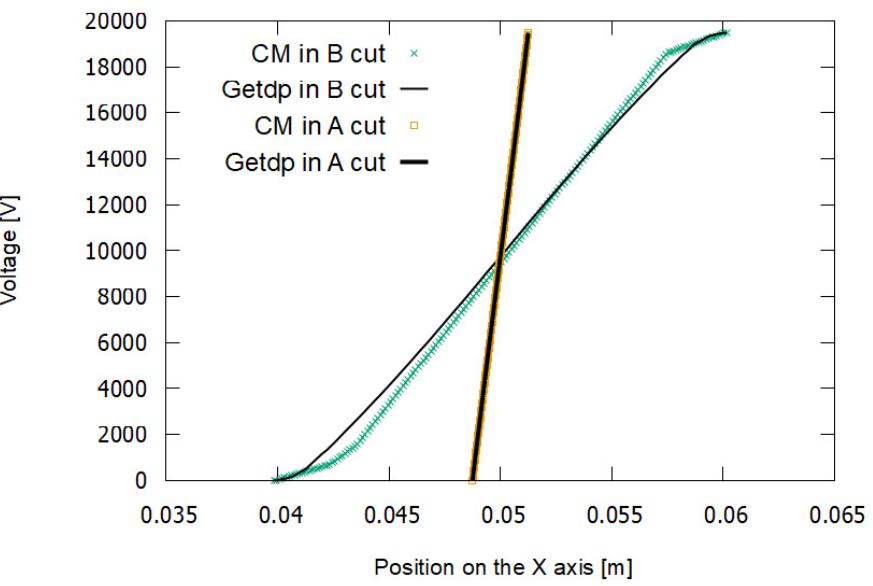
Figure 13. Voltage in cut A (steeper curves) and cut B (curves with lower slope) for experiment E1. The dielectric breakdown voltage is 19,488 V.